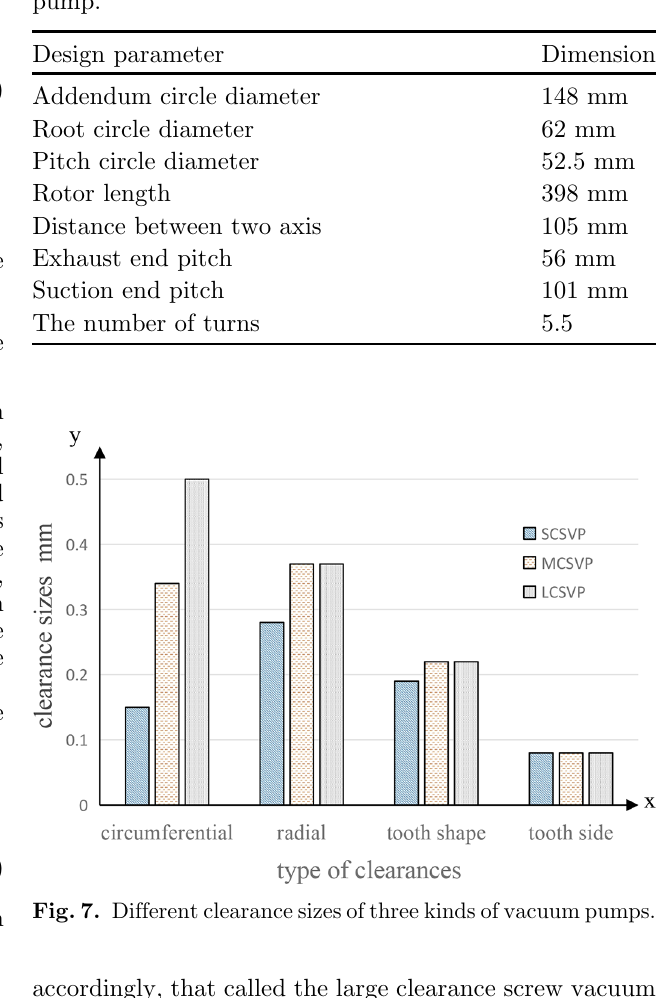
Table 1. Dimensions of variable-pitch screw vacuum pump.